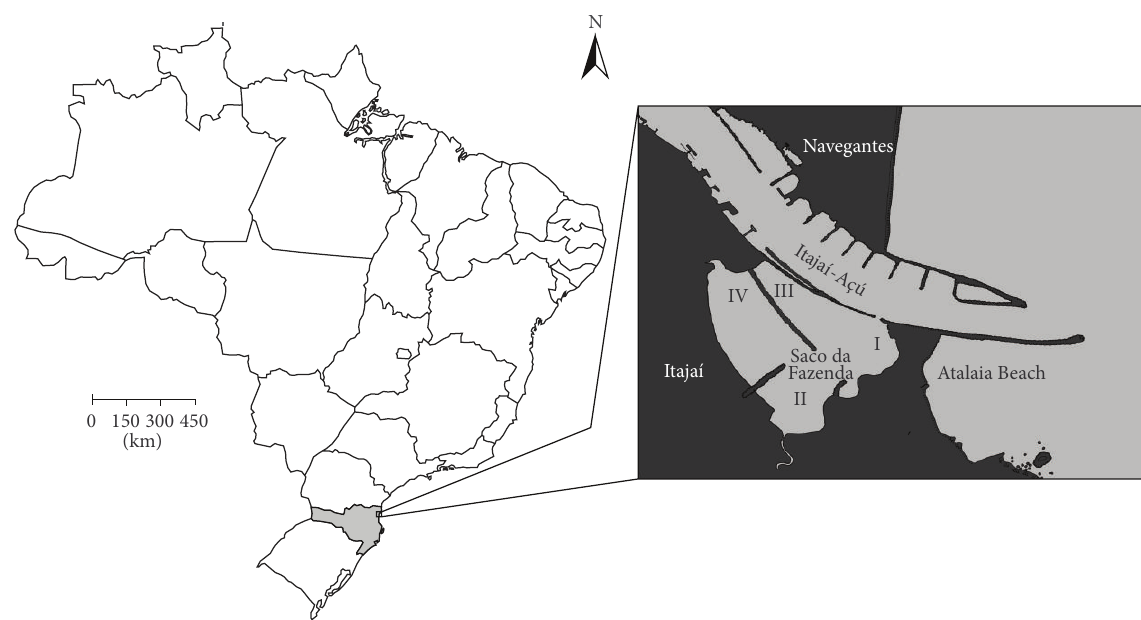
Figure 1: Studied area indicating the collecting sites in Saco da Fazenda, Santa Catarina, Brazil (source: modified of chart 1801 from Diretoria de Hidrografia e